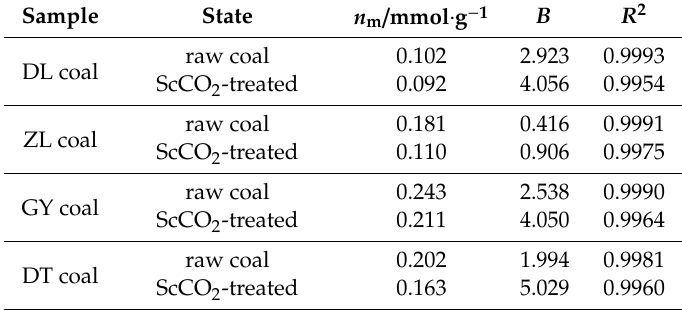
Figure 10. Adsorption isotherms of CO 2 on the raw and ScCO 2 -treated coal samples at 40 °C and the fitting curves by Langmuir model: ( a ) DL coal; ( b ) ZL coal; ( c ) GY coal; ( d ) DT coal. Table 3. Fitting parameters of the Langmuir model for CO 2 adsorption at 40 °C.